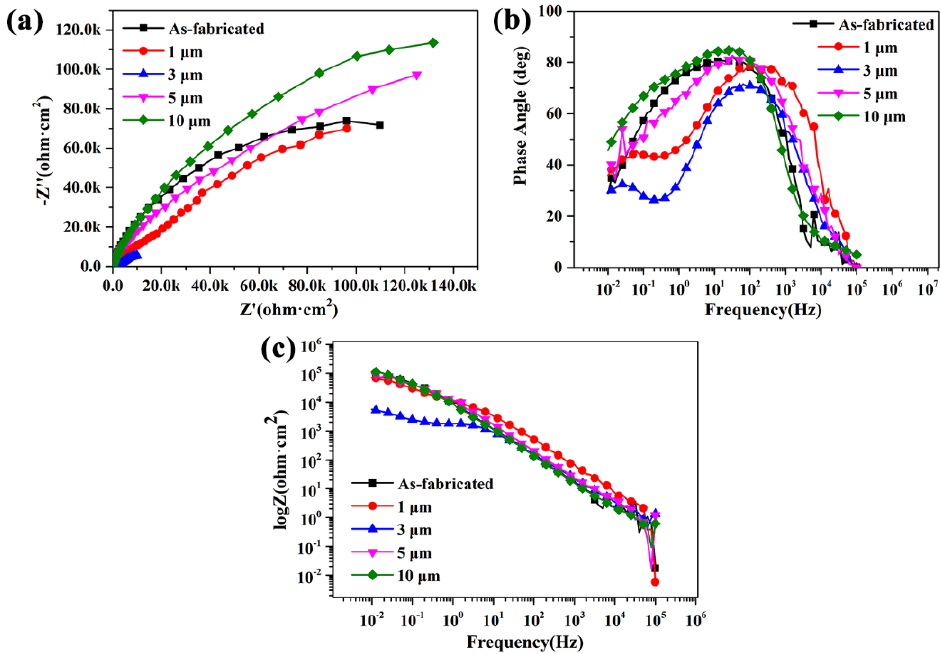
Figure 9. EIS of the different samples ( a ) Nyquist curves ( b ) Bode phase ( c ) Bode impedance.